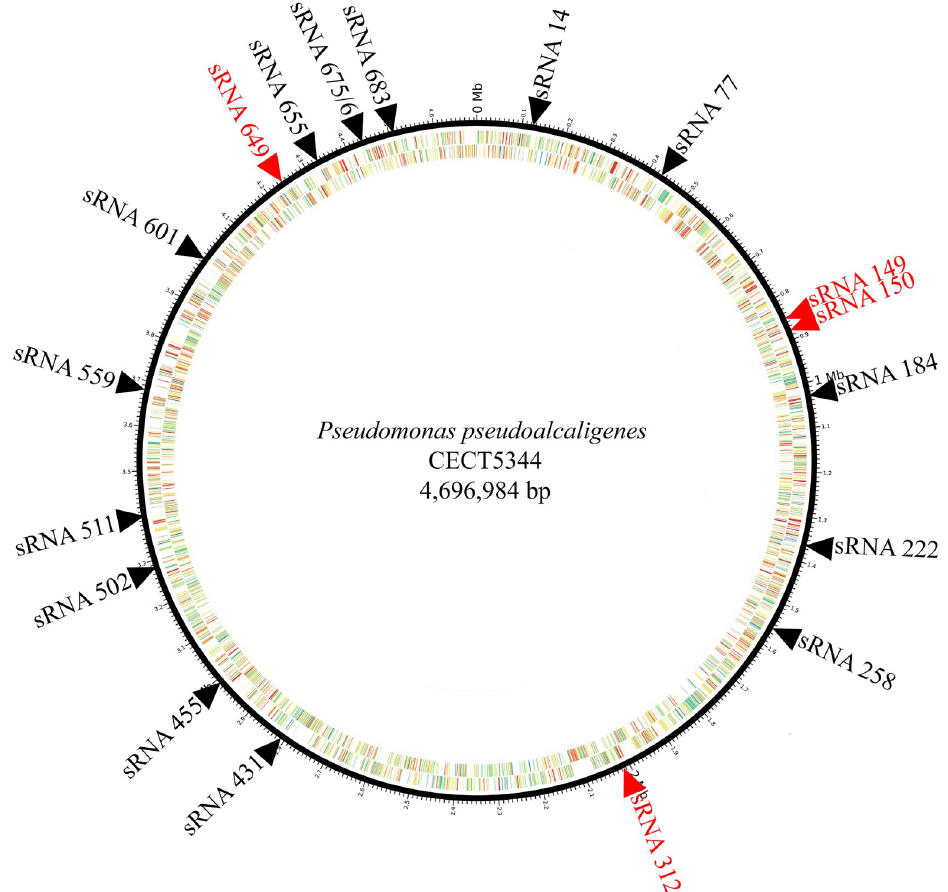
Fig 1. Localization of putative sRNAs differentially expressed (cyanide-containing wastewater versus ammonium) in the genome of P . pseudoalcaligenes CECT5344. The twenty sRNAs with differential expression (cyanide- containing wastewater/ammonium) are located within the genome of the strain CECT5344 (for genome information see reference [22]). The intergenic sRNAs are shown in black and the antisense sRNAs in red.